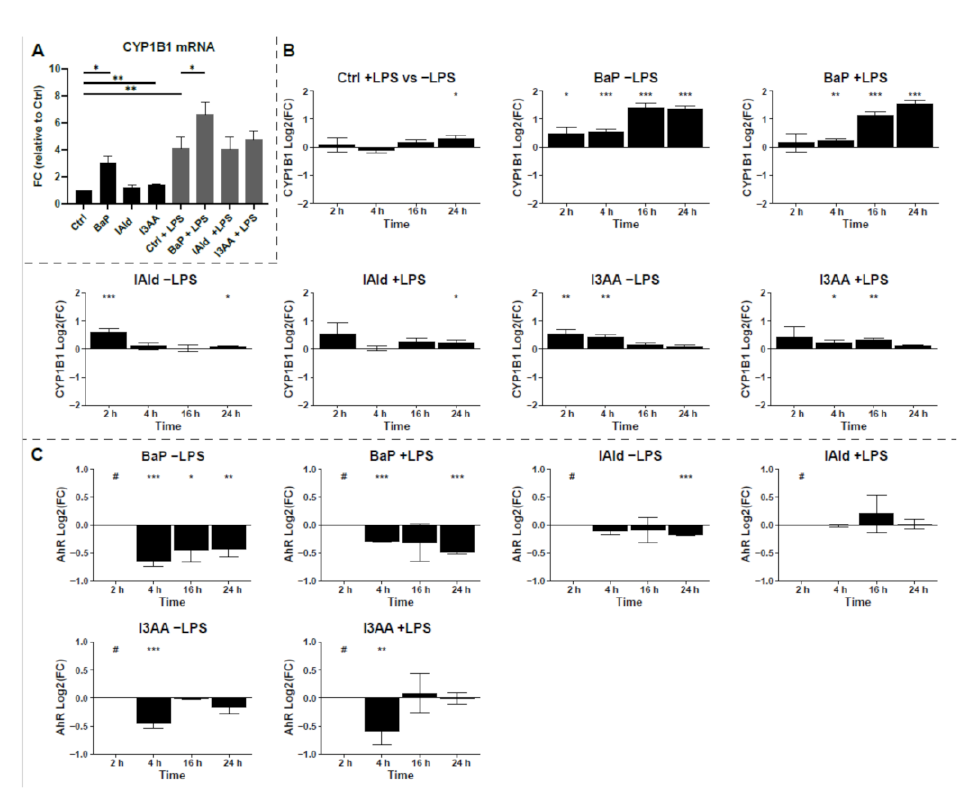
Figure 3. Induction of CYP1B1. ( A ) mRNA expression of CYP1B1 was determined by qPCR after 6 h of treatment. Data were normalized to RPLP0, and the gene expression level was calculated relative to the unstimulated control. Data are shown as mean ± SEM ( n = 5). Significances were calculated by a two-sided, paired t -test. ( B ) Relative protein abundances of CYP1B1 compared to untreated control samples or LPS-treated control samples for co-treatment are shown as Log2(FC) over time. Macrophages were stimulated with 100 ng/mL LPS or the AhR-ligands BaP (2 µ M), I3AA (50 µ M), and IAld (50 µ M) with or without additional LPS for 2, 4, 16 and 24 h. ( C ) Relative protein abundances of AhR compared to untreated control samples or LPS-treated control samples for co-treatment are shown as Log2(FC) over time. Macrophages were stimulated the AhR-ligands BaP (2 µ M), I3AA (50 µ M), and IAld (50 µ M) with or without additional 10 ng/mL LPS for 2, 4, 16 and 24 h. The significances were determined by student’s t -test ( n = 6 for 2 h and 4 h, n = 5 for 16 h and 24 h). (* p ≤ 0.05, ** p ≤ 0.01, *** p ≤ 0.001, # below limit of detection for this time